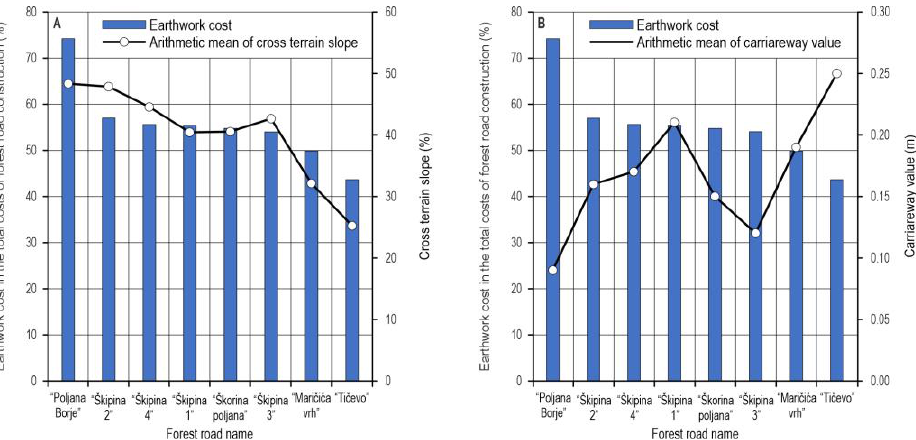
Figure 9. The influence of the cross terrain slope ( A ) and the carriageway value ( B ) on the share of earthwork costs in the total costs of the forest road